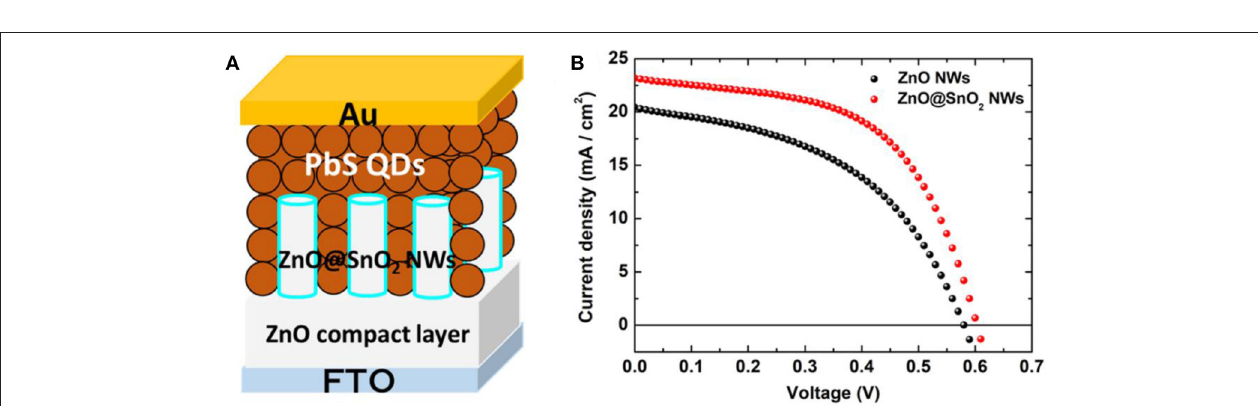
FIGURE 5 | (A) Schematic diagram of the architecture of ZnO@SnO 2 NW-based CQDSCs. (B) The J - V curves of ZnO NW CQDSCs with or without SnO 2 passivation.